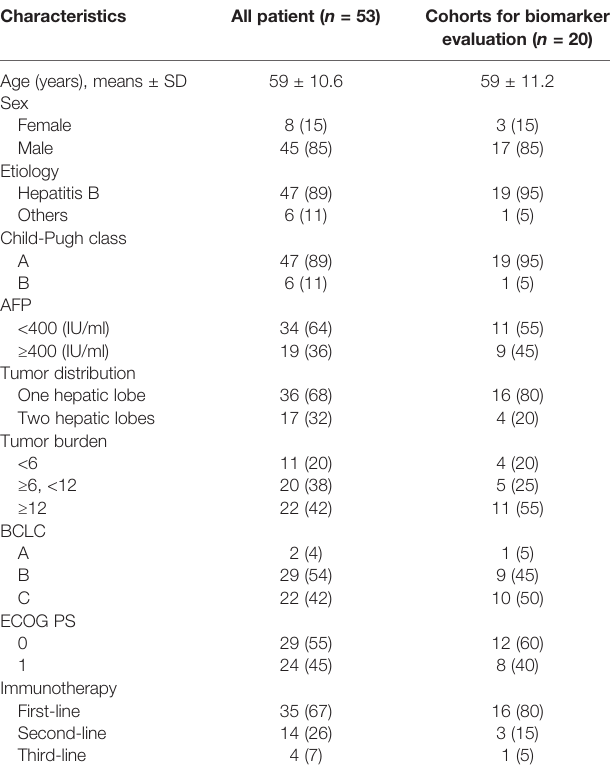
TABLE 1 | Baseline patient demographics.